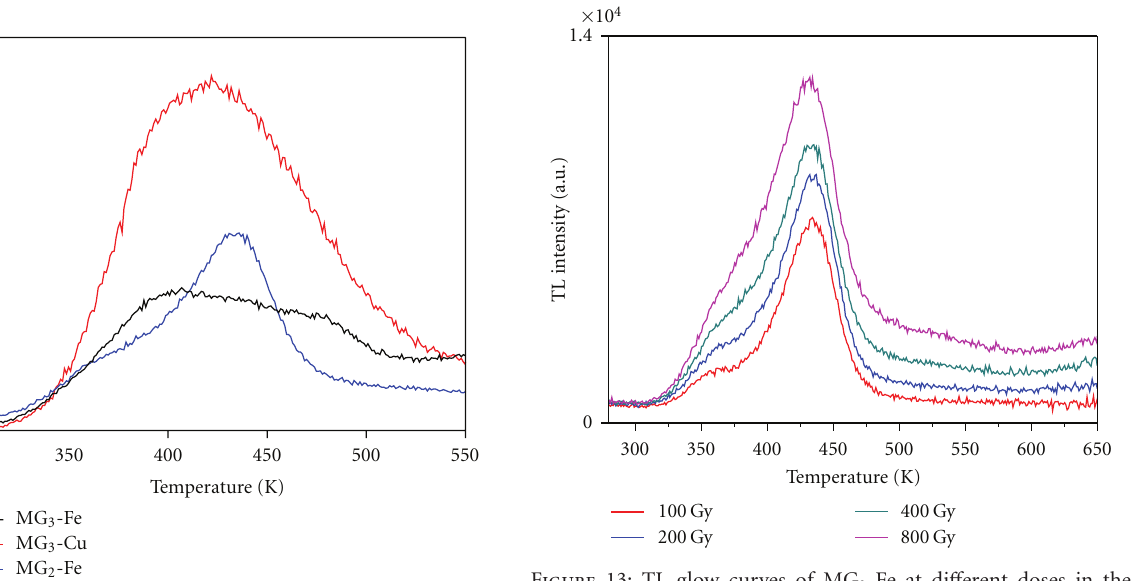
Figure 11: TL glow curves of SiO 2 glasses with di ff erent doping concentrations irradiated using a 400Gy dose.